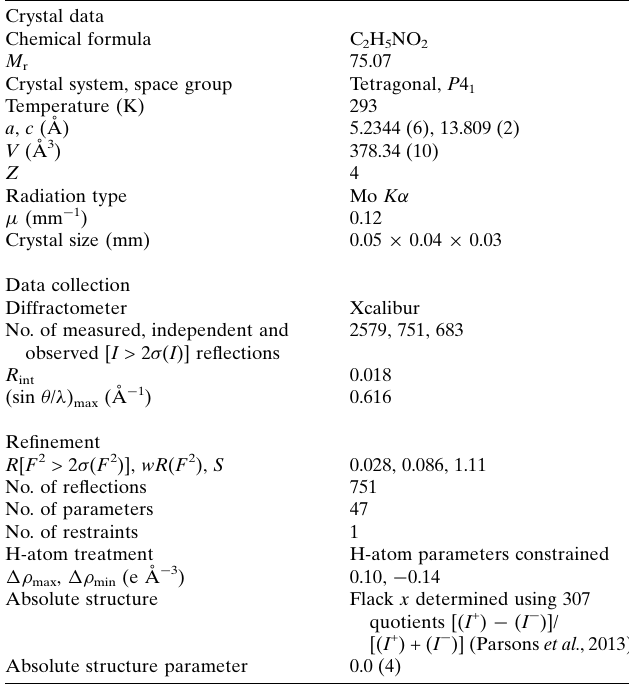
(Table 1), two N—H (cid:2) (cid:2) (cid:2) O, one O—H (cid:2) (cid:2) (cid:2) O and one C—H (cid:2) (cid:2) (cid:2) O contact. The strongest hydrogen bond in the crystalline structure of acetylhydroxamic acid is the O1—H5 (cid:2) (cid:2) (cid:2) O2 hydrogen bond. This bond creates a twisted string along the c axis. It can be assumed that the next two hydrogen bonds of the type N—H (cid:2) (cid:2) (cid:2) O have comparable strength. In the N1—